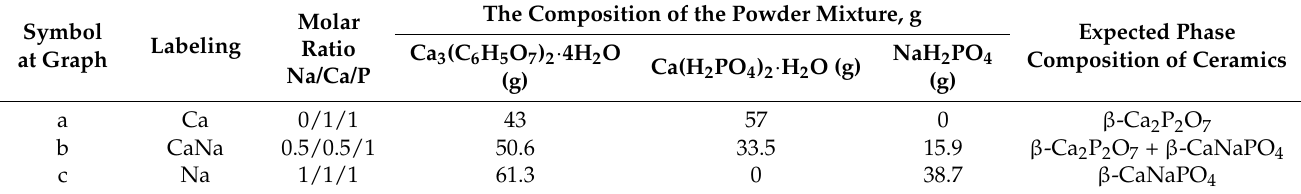
Table 1. The expected phase composition of the ceramic materials and corresponding composition of the powder